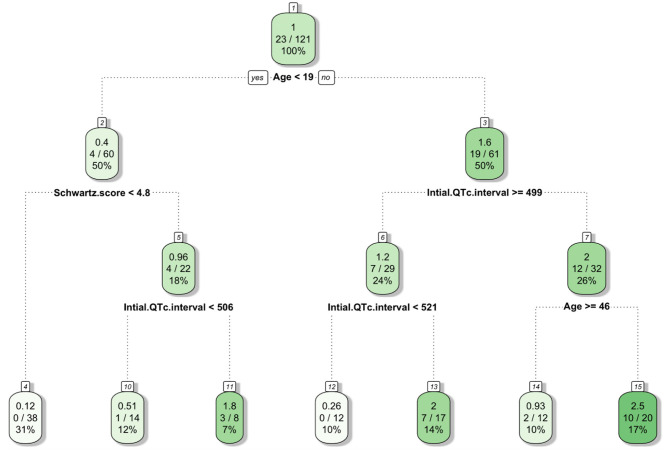
Decision rules generated by RSF model to predict VT/VF post-diagnosis.